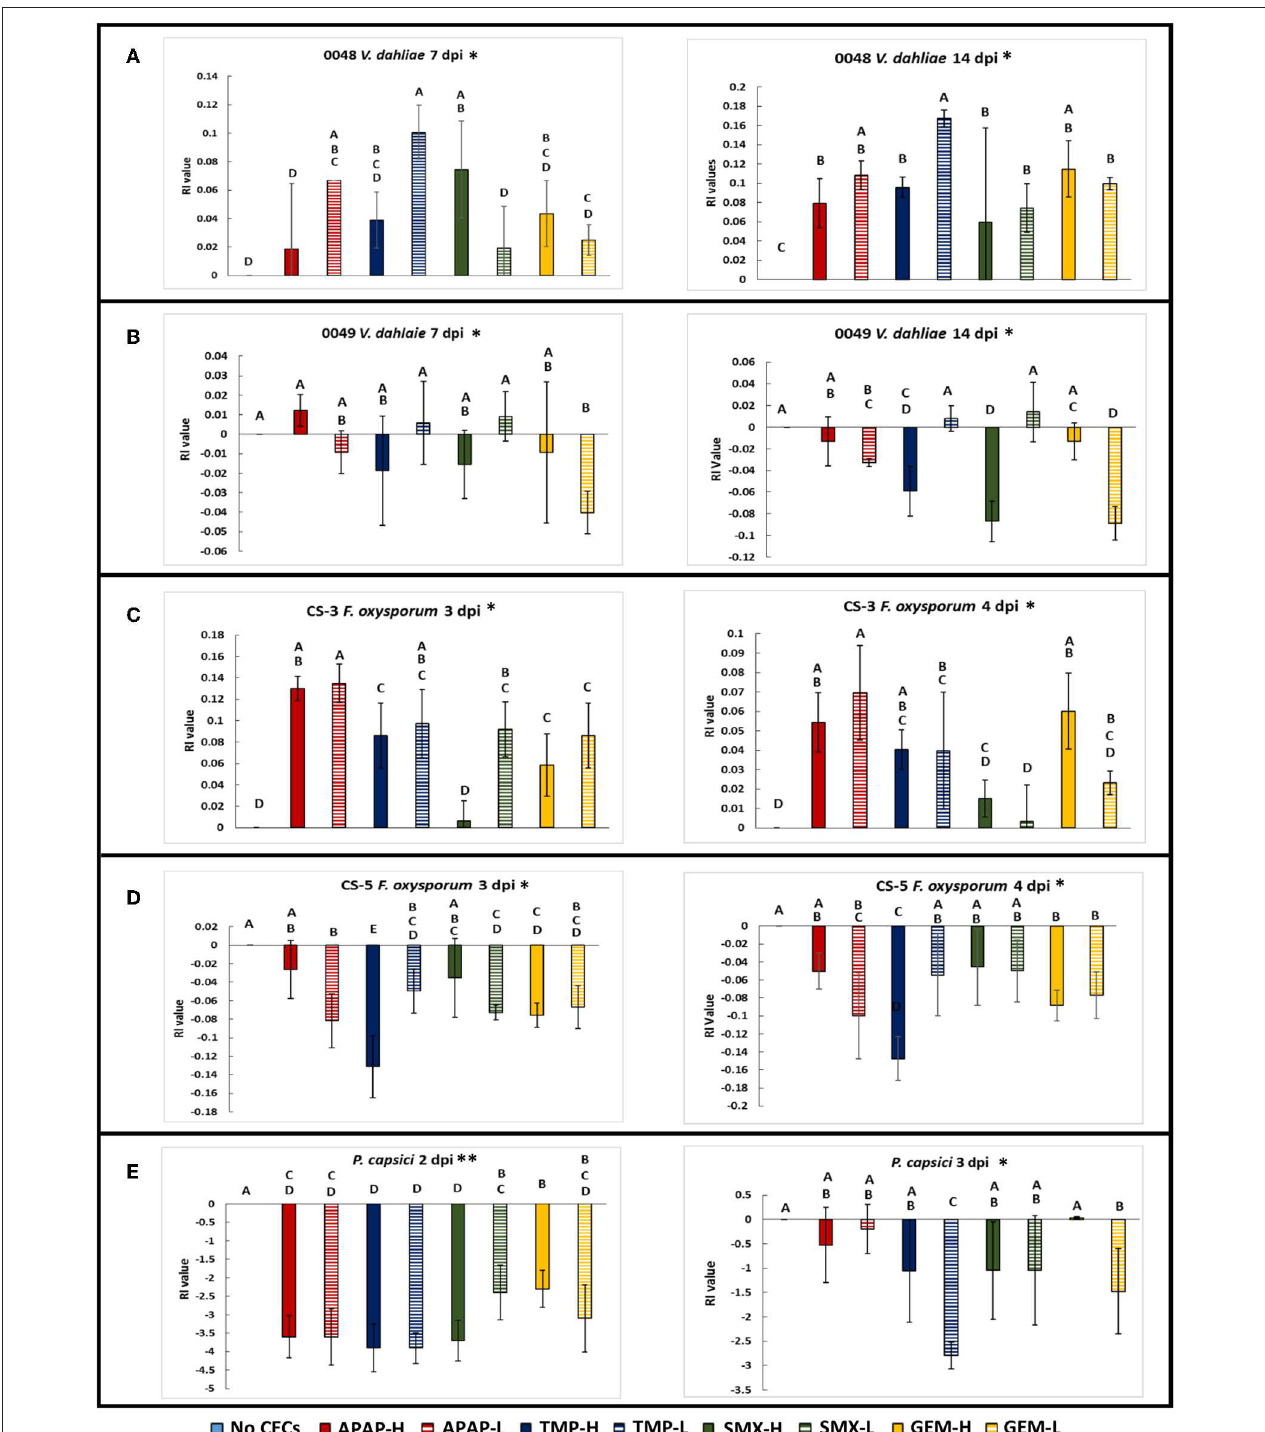
FIGURE 2 | Comparing the Allelopathic index values (RI) of the plant pathogens used in this study. (A) Verticillium dahliae strain 0048 measured at 7 and 14 dpi, (B) Verticillium dahliae strain 0049 measured at 7 and 14 dpi. (C) Fusarium oxysporum f.sp lycopersici strain CS-3 measured at 3 and 4 dpi. (D) Fusarium oxysporum f.sp lycopersici strain CS-5 measured at 3 and 4 dpi. (E) Phytopthora capsici measured at 2 and 3 dpi. *Samples compared statistically using GLiM with normal distribution and identity link function, pairwise analyses with sequential Bonferroni pairwise correction for multiple comparisons ( P < 0.05). **ANOVA used for statistical analyses, post-hoc Tukey test used for pairwise analyses ( P < 0.05).